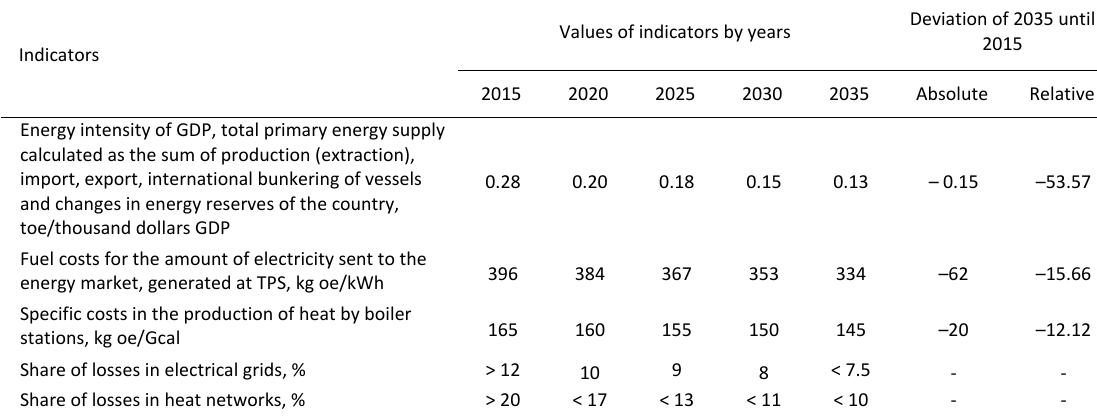
Fig. 6: Scenarios of blockchain use in energy sector projects Table 6: Indicators of the level of energy efficiency of the energy system of Ukraine until 2035 based on the use of blockchain technology